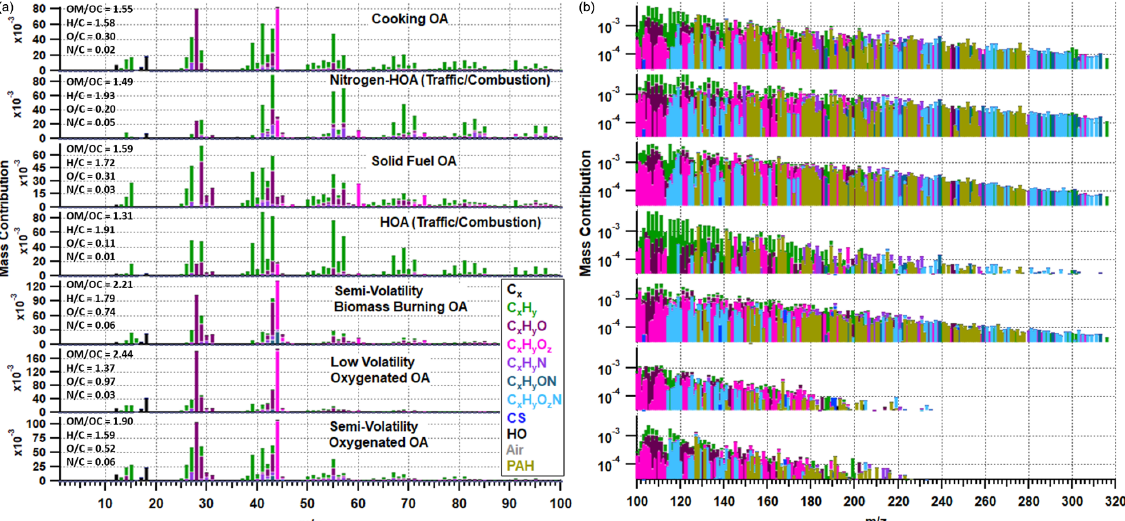
Figure 5. Organic-only PMF solution with elemental ratios shown for each factor in the left-hand corner of each spectrum. The mass spectra on the left show m/z 12–100 on a linear scale, while the spectra to the right show m/z 100–320 on a logarithmic scale. The peaks are coloured based on the chemical families shown in the